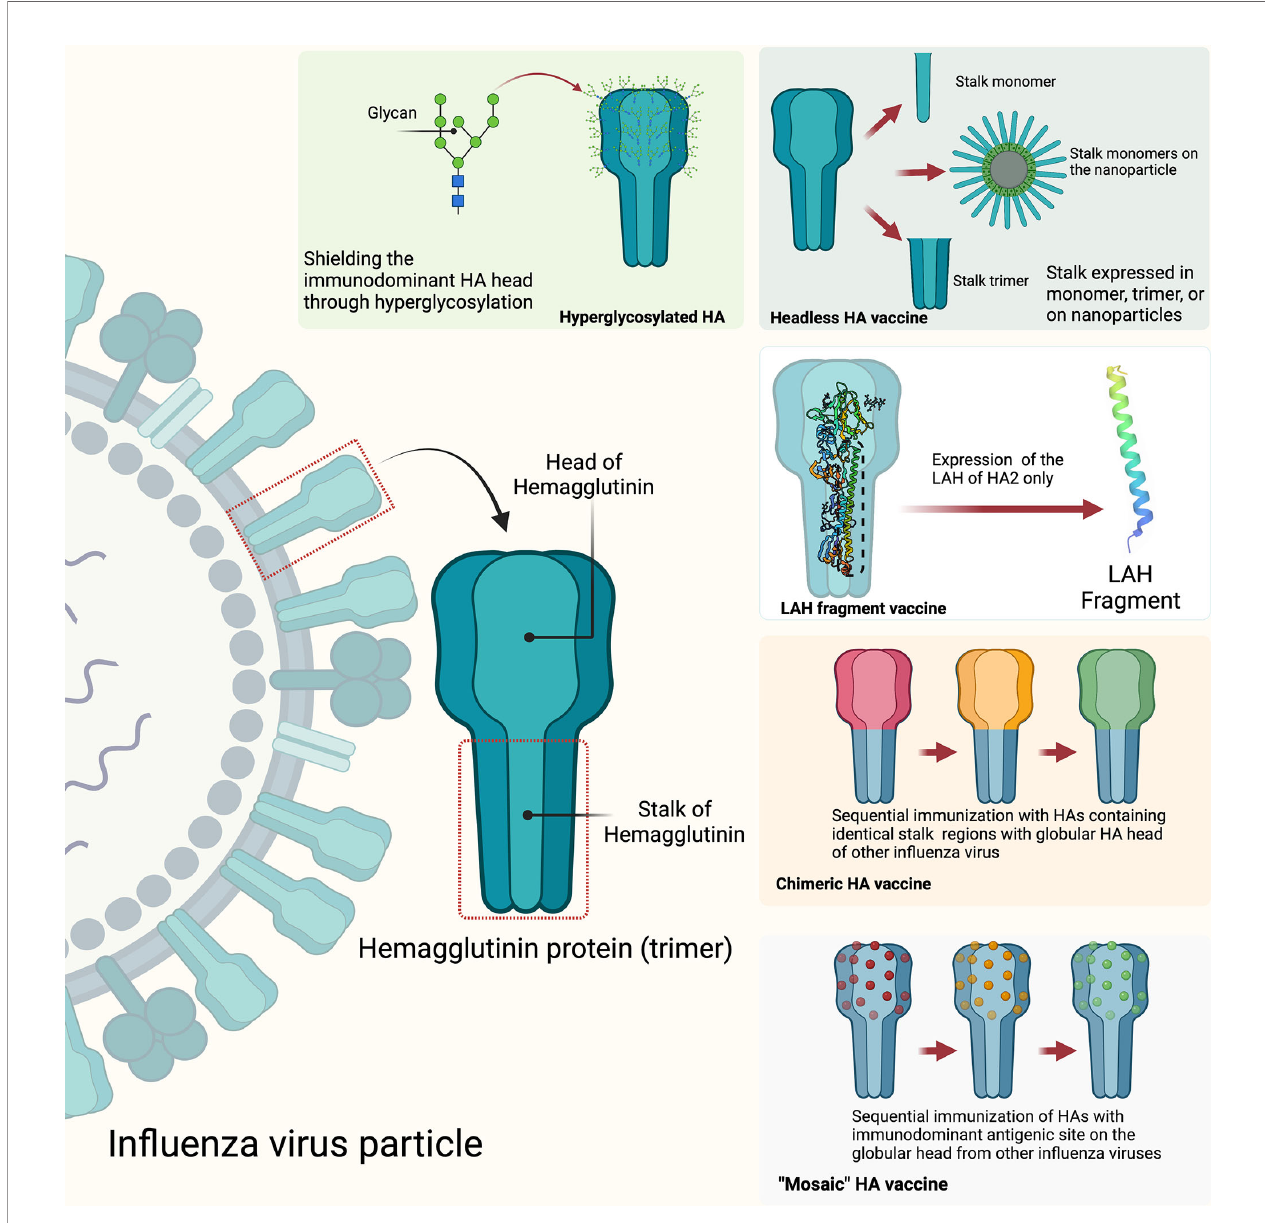
FIGURE 4 | Strategies to develop HA stalk-directed universal in fl uenza vaccines: hyperglycosylated HA, headless HA, long alpha helix (LAF) fragment, chimeric HA, and mosaic HA. The fi gure was created with